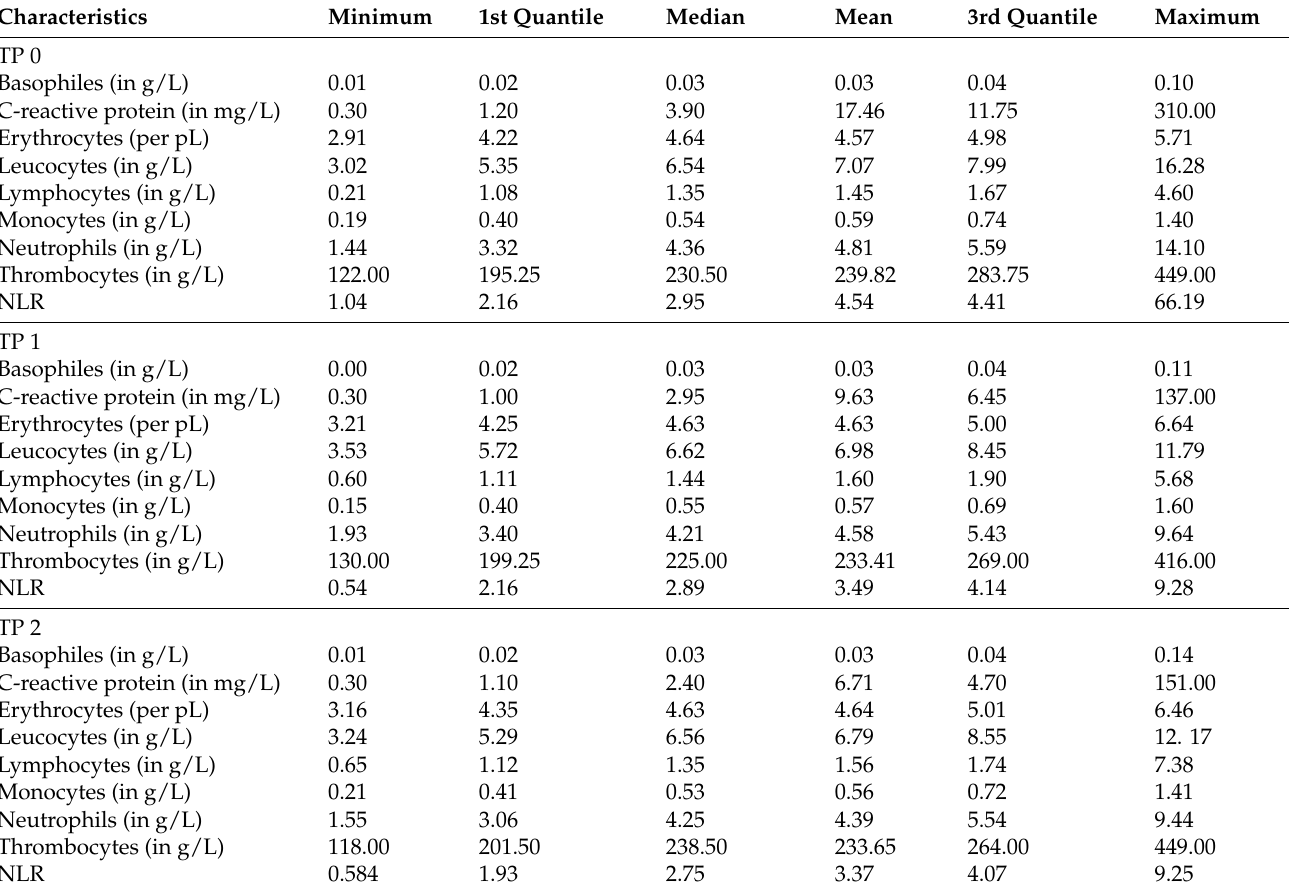
Table 2. Descriptive statistics of blood parameters in patients with disease control after six months of ICIs at baseline (TP 0), three months (TP 1), and six months (TP 2).